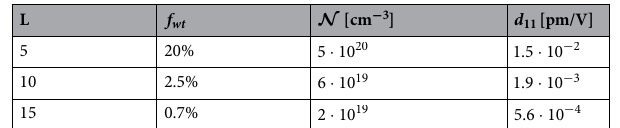
( 2 ε 0 ) − 1 χ ( 2 ) in the very weak poling regime, Eq. (36), for a few = ˜